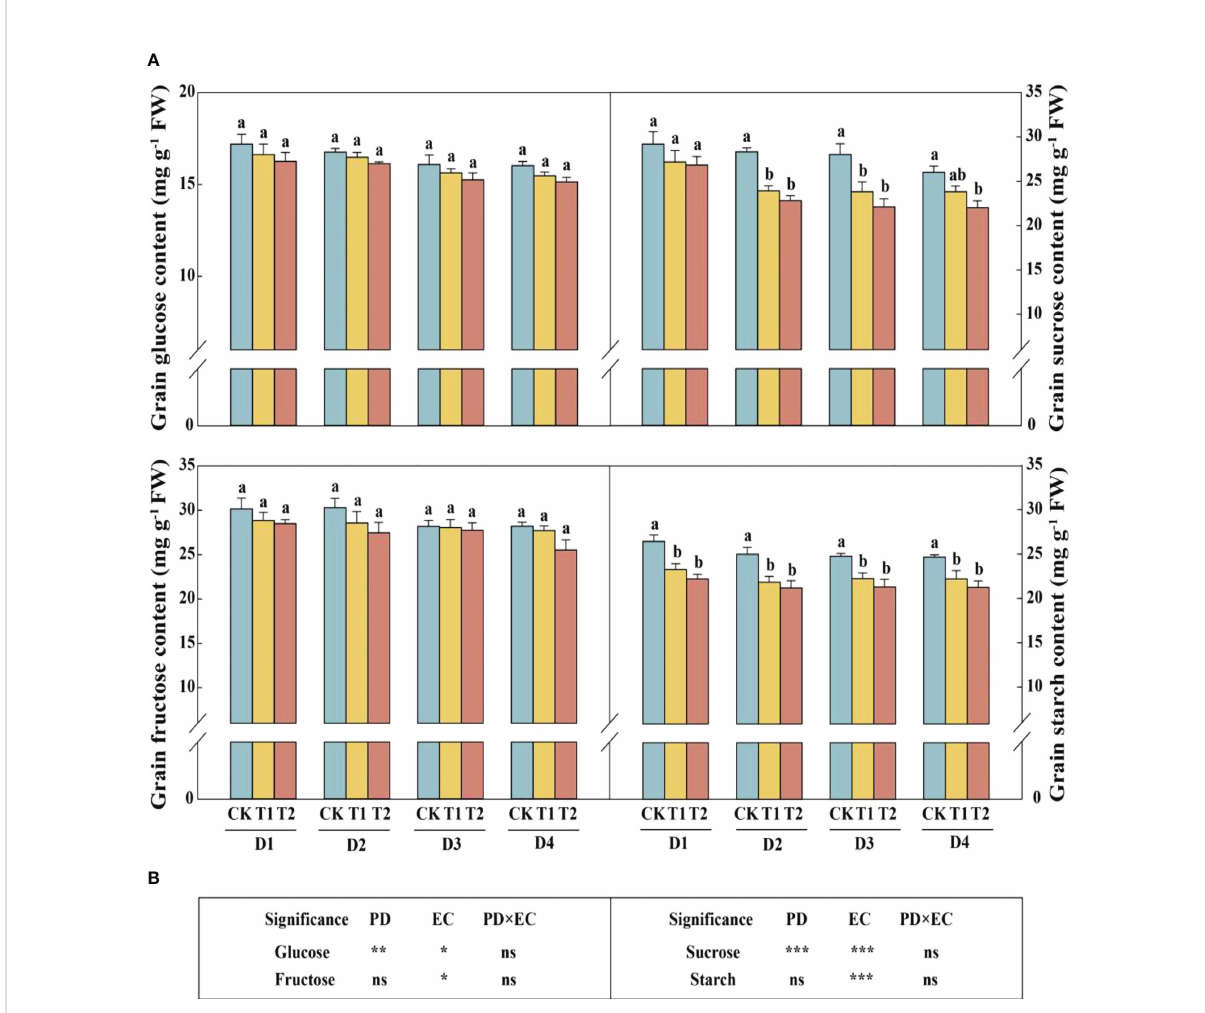
FIGURE 5 Effects of EC and PD on glucose, sucrose, fructose, and starch in the grains of summer maize in 2021 (A) . Results of ANOVA on the effects of plant density (PD), EC treatments (EC) and their interaction (PD×EC) on glucose, sucrose, fructose, and starch in the grains in 2021 are listed (B) . Different lowercase letters indicate signi fi cant differences between EC treatments at each plant density. ns means non-signi fi cant. *, ** and *** indicate signi fi cant differences at P< 0.05, < 0.01 , and < 0.001 probability levels, respectively. EC, plant growth regulator; PD, plant density; D1, D2, D3, and D4 indicated plant density at 4.5, 6.0, 7.5, and 9.0 plants m − 2 , respectively; CK, T1, and T2 indicated water control, 2 mL L − 1 EC (ethephon: cycocel = 3:1), 4 mL L − 1 EC,